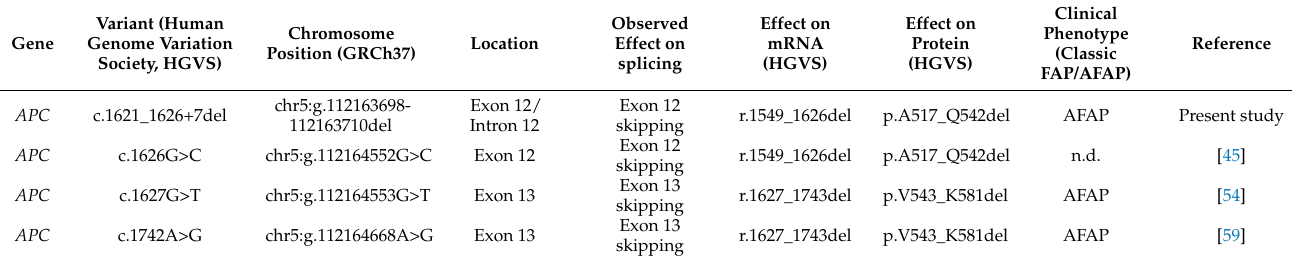
Table 1. APC splicing mutations leading to an in-frame protein and skipping of exon 12 or exon 13. Variant (Human Gene Genome